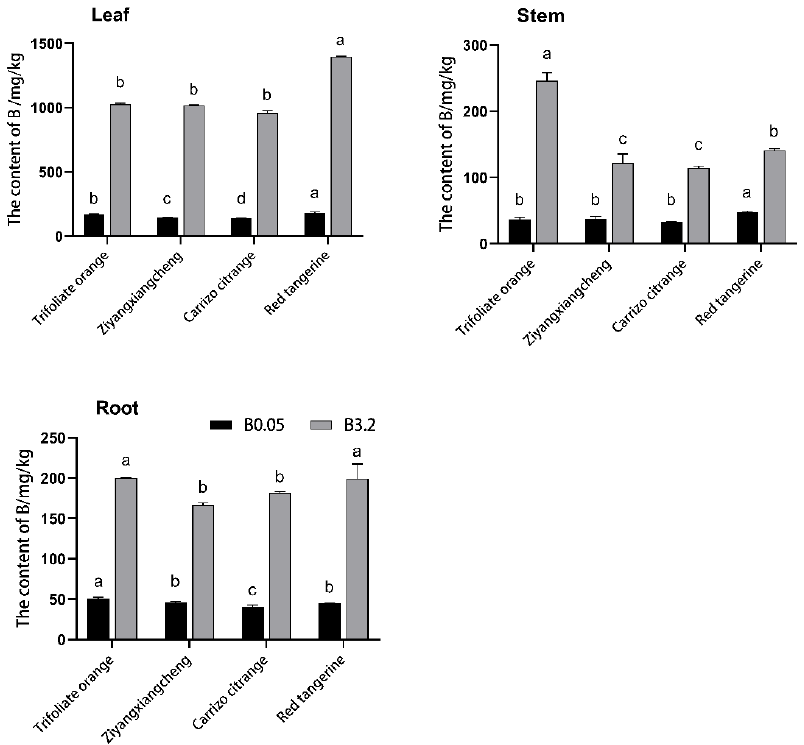
Figure 4. The impact of B 0.05 and B 3.2 conditions on B content in different four citrus rootstock seedlings. Note: B 0.05 served as the control (CK) concentration, and data were compared with Duncan’s multiple range test. Different letters indicate significant differences between rootstocks at the same B concentration ( p < 0.05).